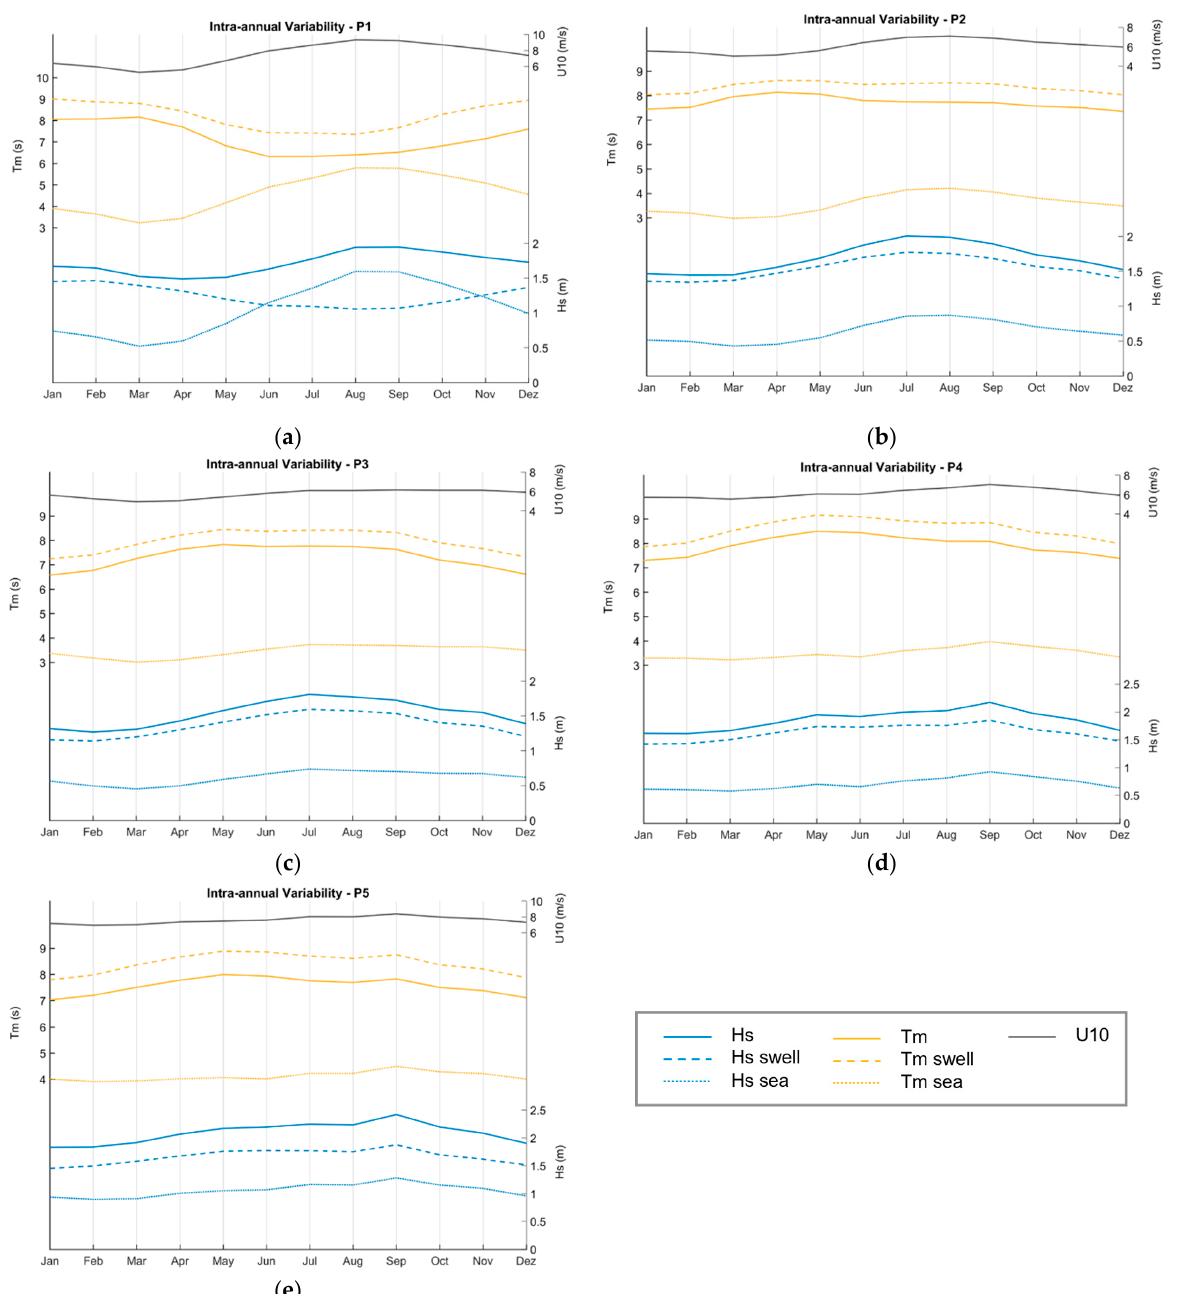
Figure 11. Intra-annual variability of U 10 (m.s − 1 ; gray line), T m (s; yellow line), T w m (s; dotted yellow line) and T s m (s; dashed yellow line), H s (m; blue line), H w s (m; dotted blue line), and H s s (m; dashed blue line) based on monthly averages for the five selected key points: P1 ( a ), P2 ( b ), P3 ( c ), P4 ( d ), and P5 ( e